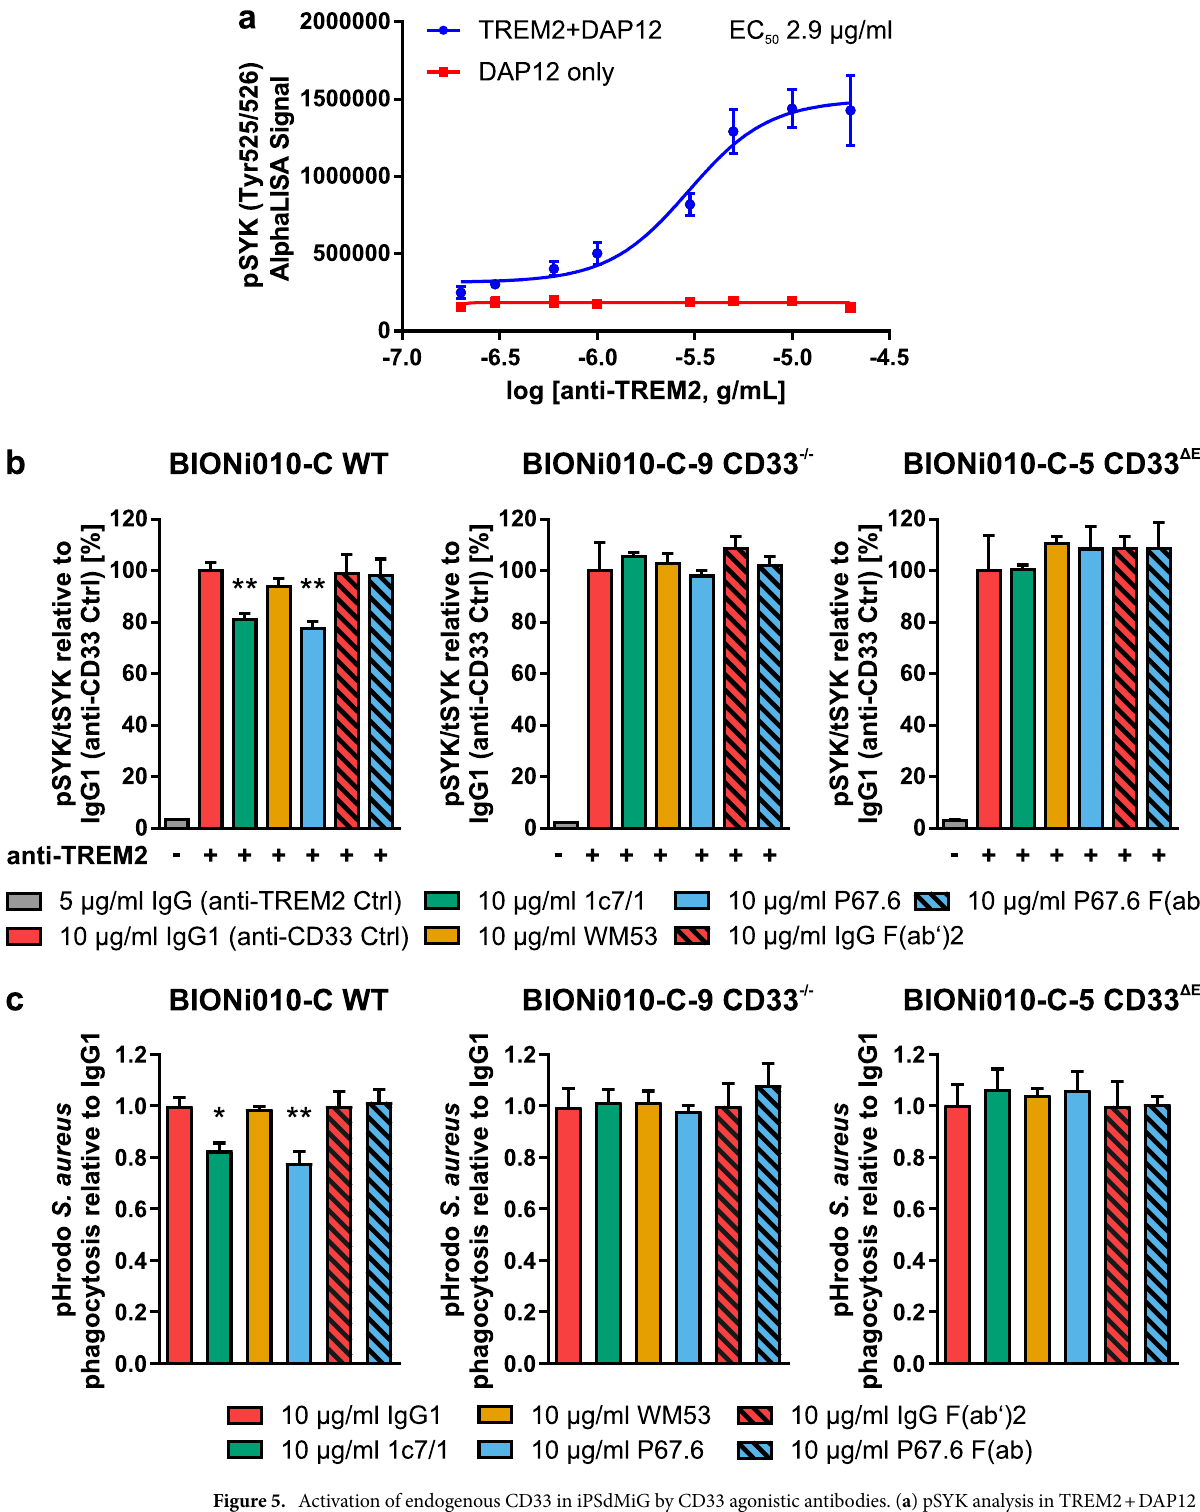
Figure 5. Activation of endogenous CD33 in iPSdMiG by CD33 agonistic antibodies. ( a ) pSYK analysis in TREM2 + DAP12 reporter cells. Addition of anti-TREM2 antibody AF1828 resulted in an increase in endogenous pSYK levels measured 30 min after the treatment only in TREM2 + DAP12 but not DAP12 expressing control reporter cells. Data are presented mean ± SD. ( b ) CD33 antibodies P67.6 and 1c7/1 were able to decrease the increased pSYK/tSYK levels triggered by TREM2 activation in WT iPSdMiG (left). In CD33 −/− (middle) and CD33 ΔE2 (right) iPSdMiG none of the tested antibodies was able to modulate pSYK/tSYK levels after TREM2 activation. Data are presented mean + SEM; n = 3–6; ** p ≤ 0.01 compared to IgG1 (anti-CD33 Ctrl) determined by Welch ANOVA followed by Games-Howell post hoc test. ( c ) CD33 antibodies P67.6 and 1c7/1 decreased the phagocytic uptake of pHrodo S. aureus BioParticles in WT iPSdMiG (left). In CD33 −/− (middle) and CD33 ΔE2 (right) iPSdMiG none of the tested antibodies was able to modulate pHrodo S. aureus BioParticle phagocytosis. Data are presented mean + SEM; n = 3; ** p ≤ 0.01 and * p ≤ 0.05 compared to IgG1 determined by ANOVA followed by Dunnett’s post hoc